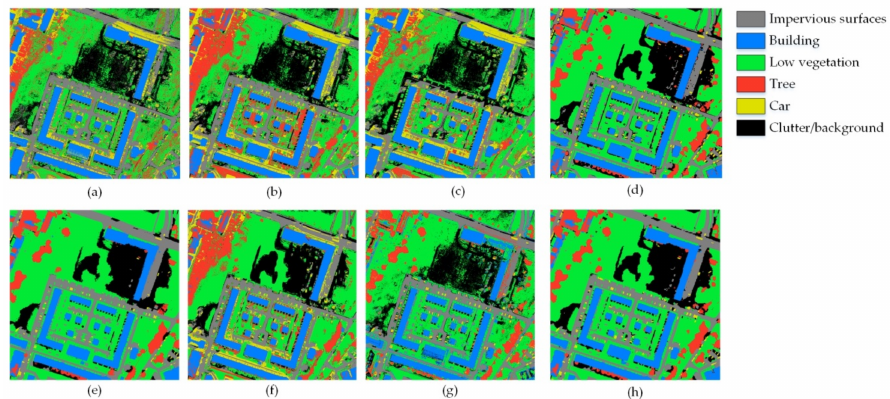
Figure 7. Comparison of the classification result images of eight methods for study image 2. ( a ) k -NN;